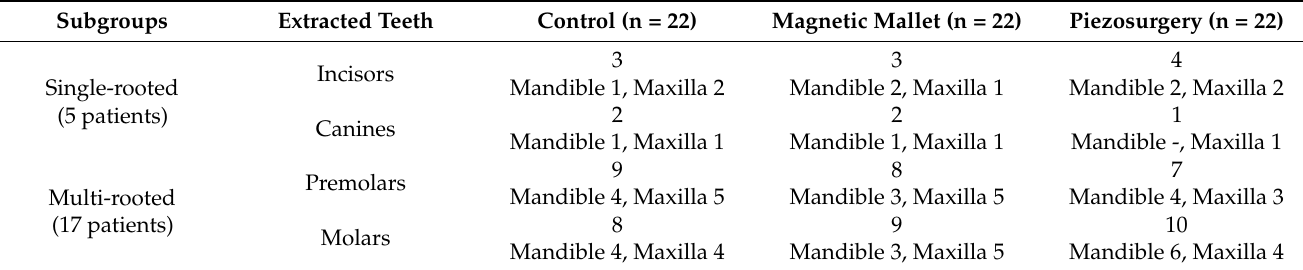
Table 2. Distribution of extracted teeth.